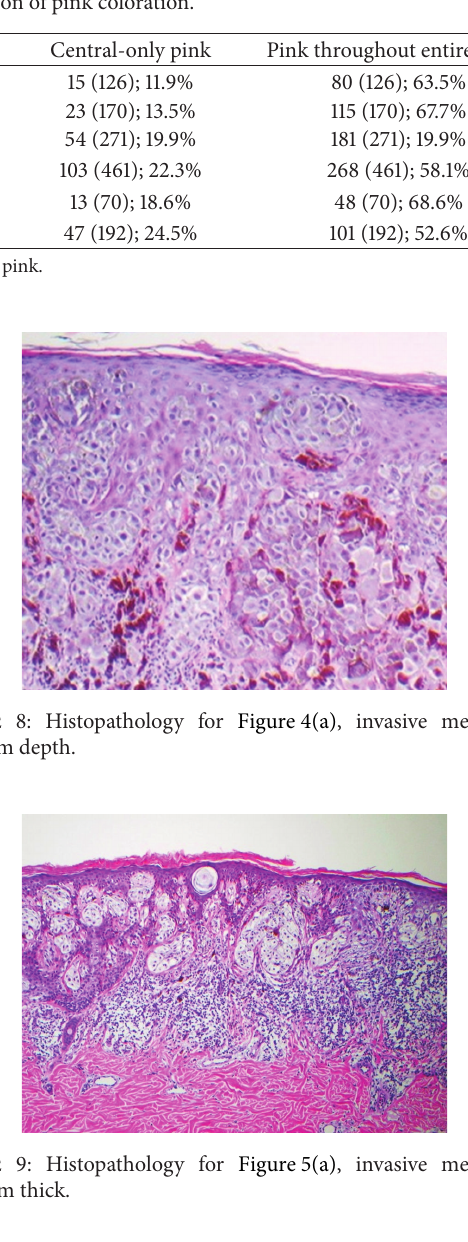
Table 1: Number of lesion types by location of pink coloration.